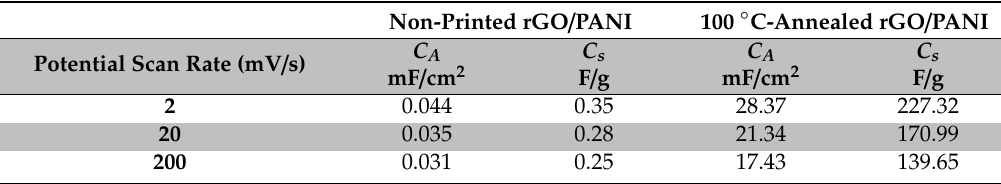
Figure 9. Cycle voltammetry results of ( a ) non-printed and ( b ) 100 ◦ C-annealed rGO / PANI supercapacitors in the scanning rates of 200, 20 and 2 mVs − 1 , respectively. Table 1. Calculated areal and specific capacitance of non-printed and 100 ◦ C-annealed rGO / PANI supercapacitors based on cyclic voltammetry (CV)